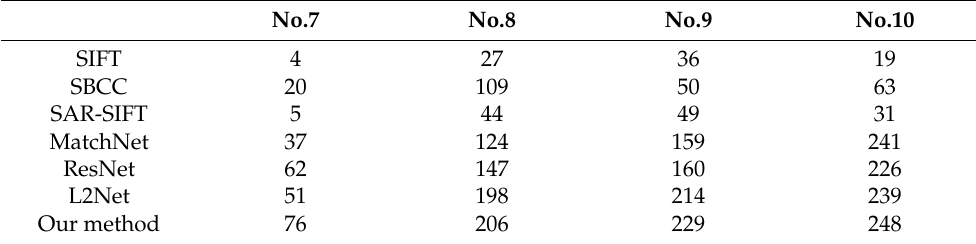
Figure 12. Performance of the four sets of data with different polarization modes. ( a ) Accuracy. ( b ) Recall. ( c ) F-score. Table 5. The Number of Point